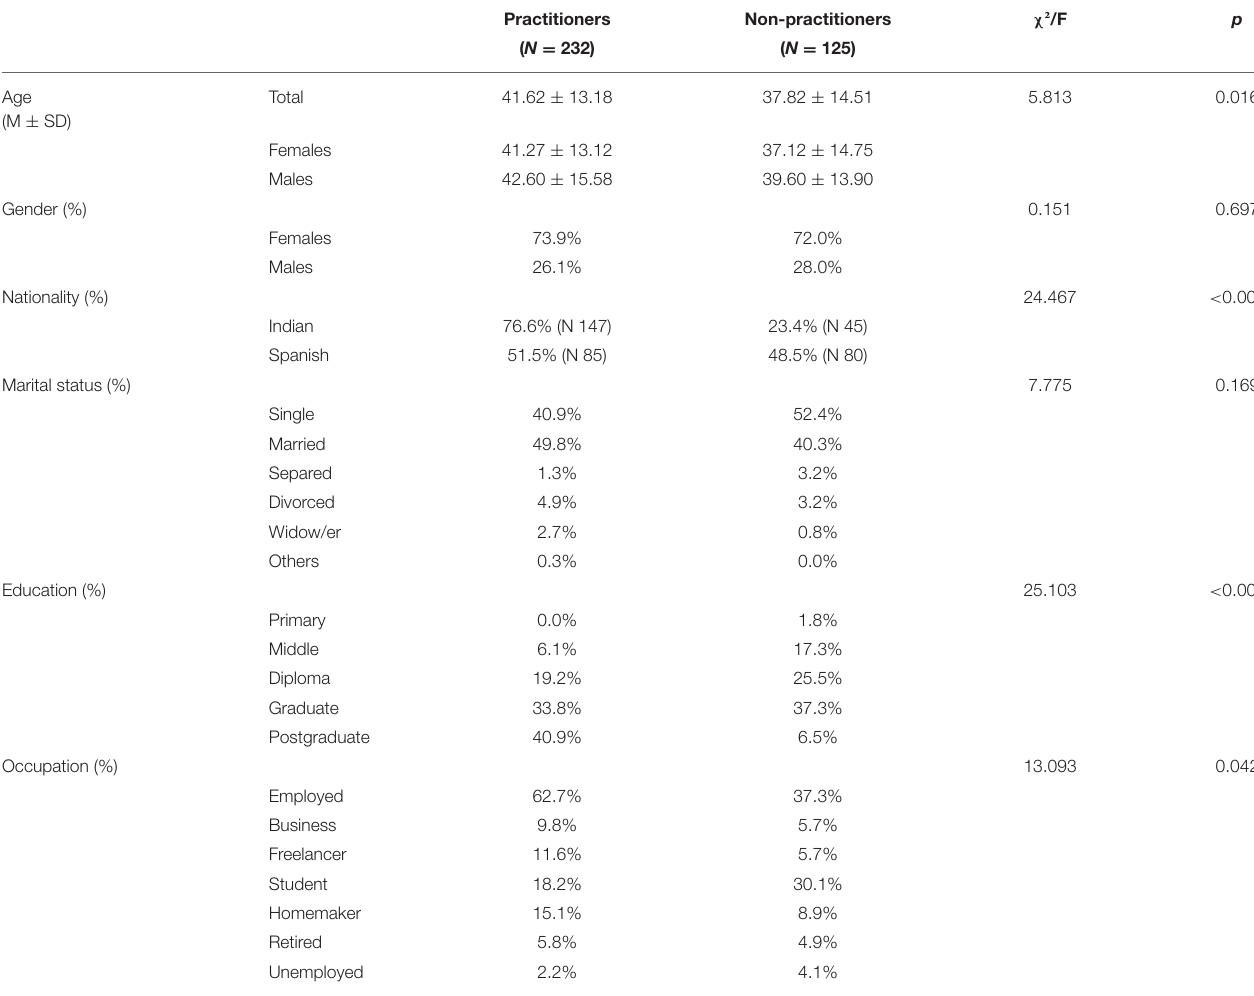
TABLE 1A | Descriptive statistics and differences between yoga practitioners and non-practitioners (NP) in sociodemographic variables.